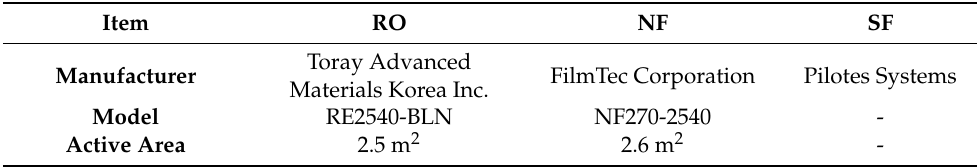
Table 2. Information about Filtration Techniques.